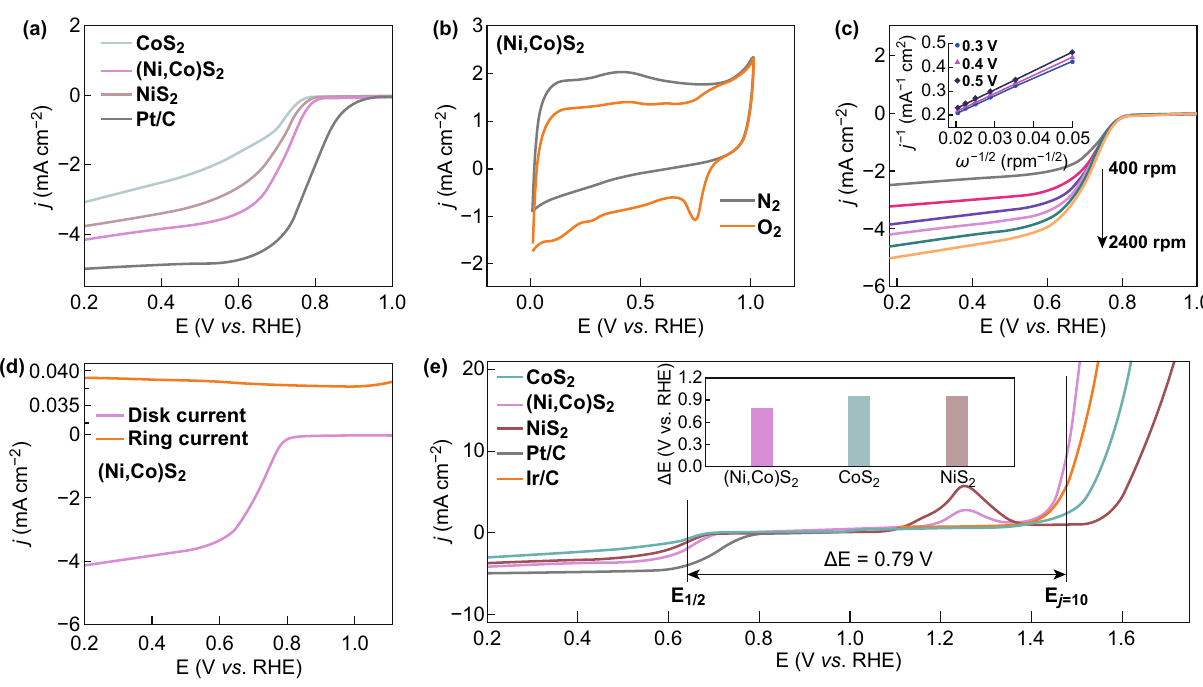
Fig. 4 a ORR polarization curves of (Ni,Co)S 2 , NiS 2 , CoS 2 , and Pt/C (20% Pt) at 2 mV s −1 in 0.1 M KOH at 1600 rpm. b CVs of (Ni,Co) S 2 in O 2 and N 2 -saturated 0.1 M KOH solution. c ORR polarization curves of (Ni,Co)S 2 at different rotation rates from 400 to 2400 rpm. The inset figure is the K – L plots. d RRDE polarization curves of (Ni,Co)S 2 at 1600 rpm. The ring electrode was polarized at 1.5 V at a scan rate of 2 mV s −1 . e Bifunctional electrocatalytic activities of various catalysts toward both ORR and